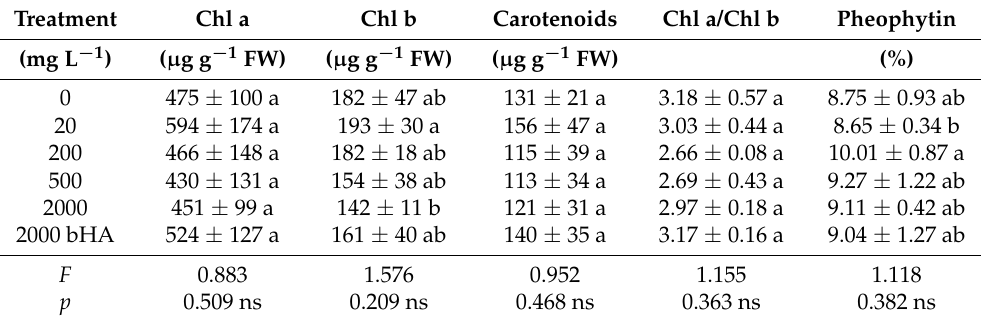
Table 2. One-way ANOVA analysis performed on photosynthetic pigments of S. lycopersicum seedlings to evaluate the effect of different concentrations of CMC- n HA and bHA.